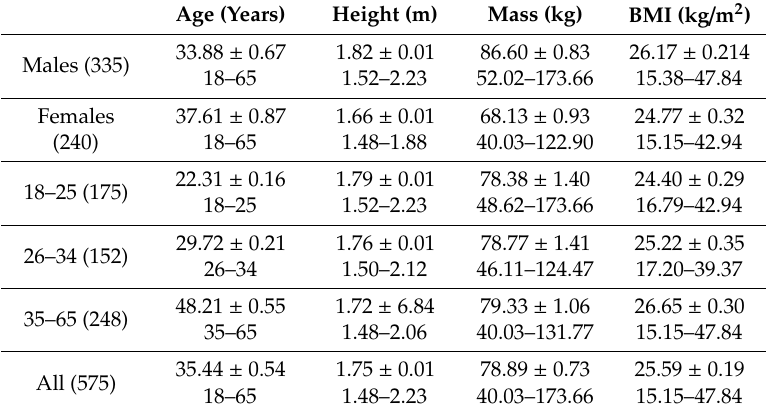
Table 2. Demographics and anthropometric characteristics for the patients (number of subjects, mean ± SEM and range). Values are grouped by sex and the breakdown between the three age groups are also